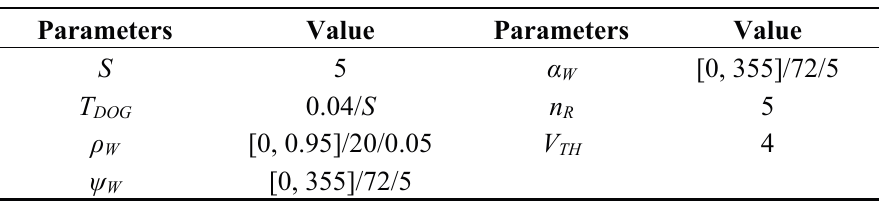
Table 1. Parameters for the experiments.